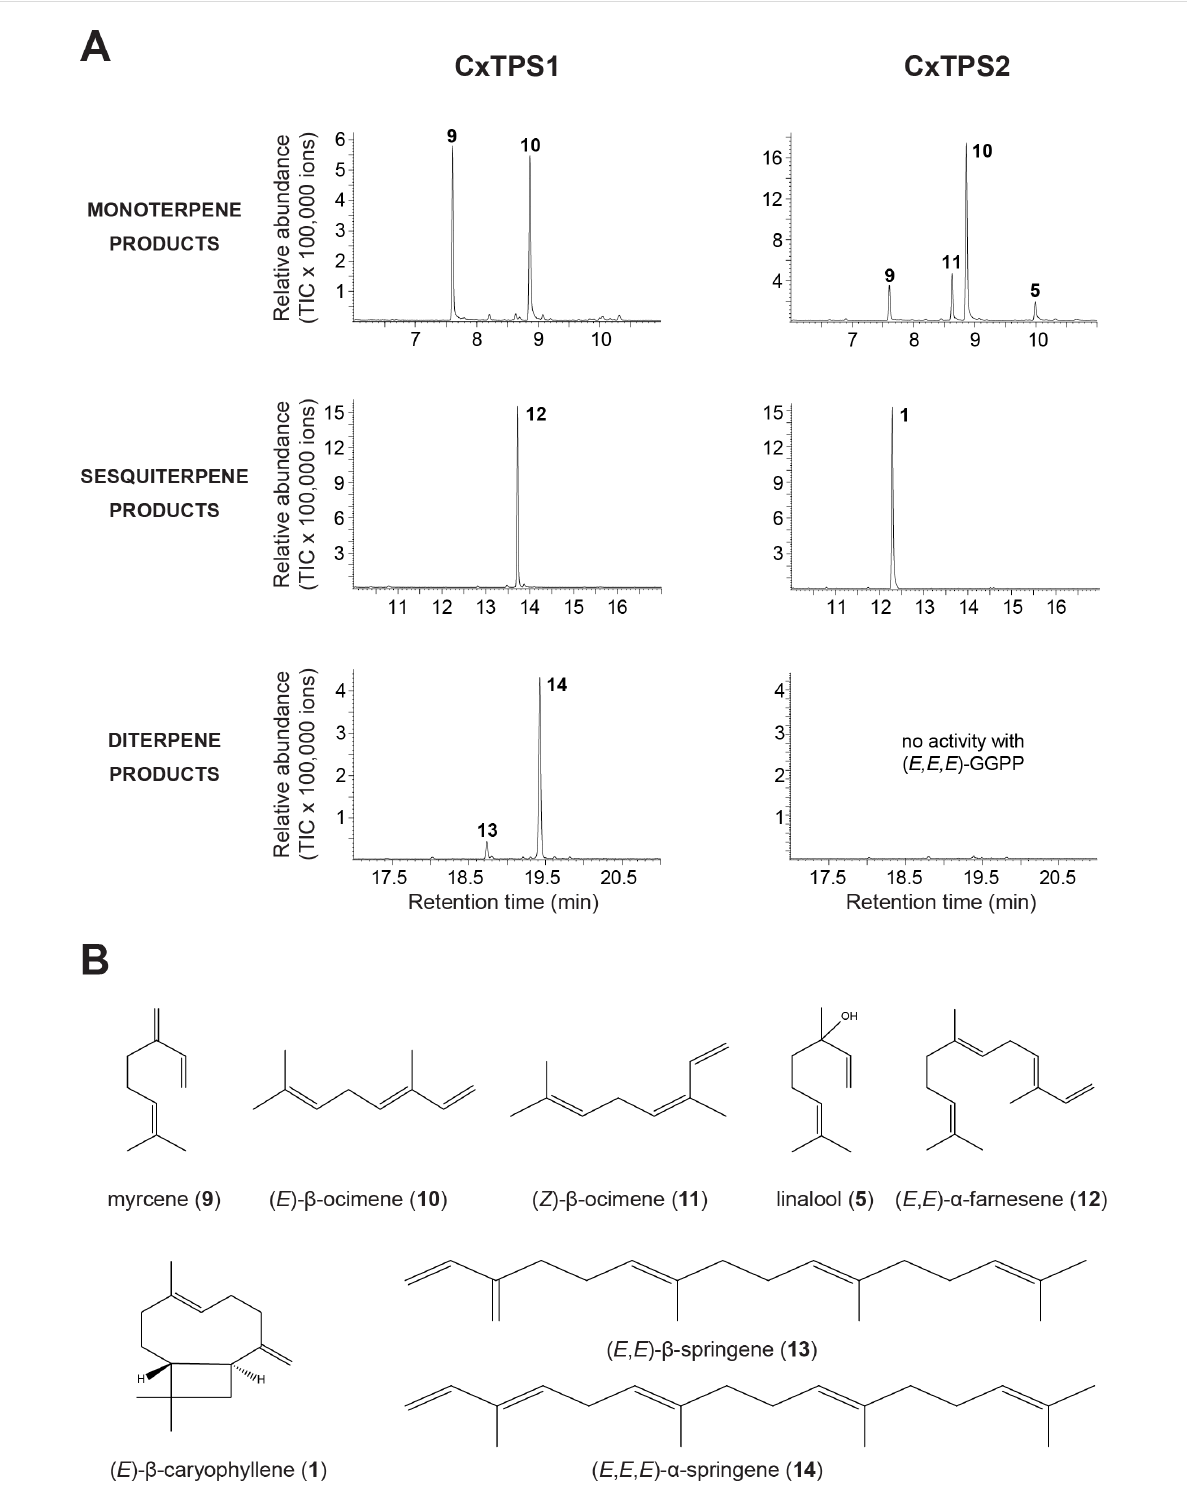
Figure 2: Terpene synthase activity of CxTPS1 and CxTPS2. A) Genes were heterologously expressed in Escherichia coli and partially purified pro- teins were assayed with GPP, ( E , E )-FPP, or ( E , E , E )-GGPP as substrates in the presence of 10 mM MgCl 2 . Enzyme products were extracted from the assays with hexane and analyzed using gas chromatography–mass spectrometry. Myrcene ( 9 ); ( E )- β -ocimene ( 10 ); ( Z )- β -ocimene ( 11 ); linalool ( 5 ); ( E , E )- α -farnesene ( 12 ); ( E )- β -caryophyllene ( 1 ); ( E , E )- β -springene ( 13 ); ( E , E , E )- α -springene ( 14 ). B) Structures of the enzyme products of CxTPS1 and CxTPS2, including ( E )- β -caryophyllene ( 1 ) which was the only terpene detected from Cladosporium sp.